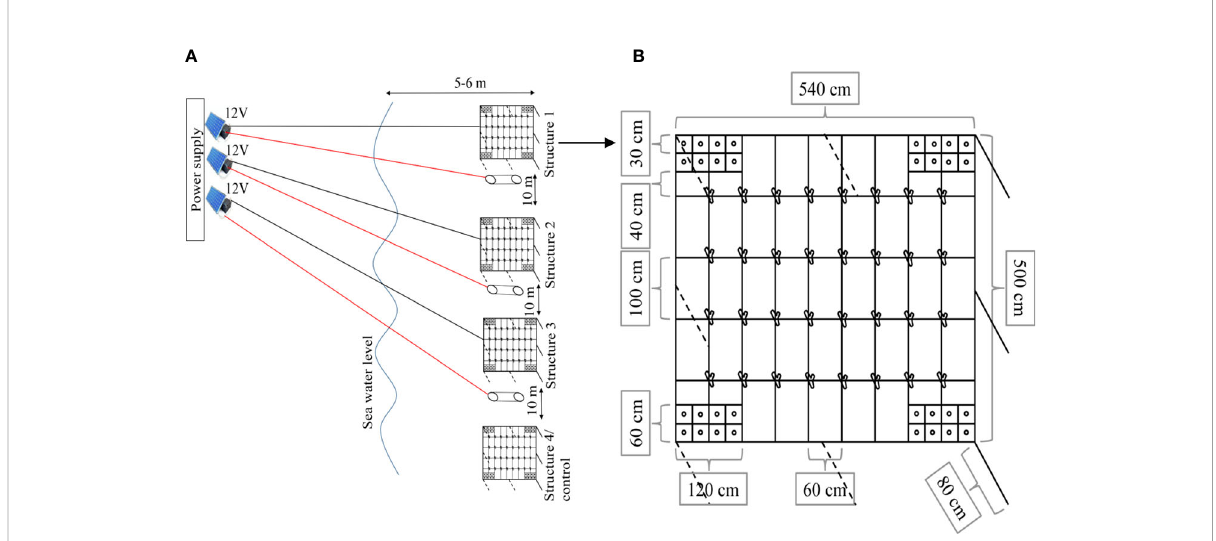
FIGURE 2 Design and setup of electro-stimulated structures for coral transplantation (A) , the schematic of cathode structure with the positions for massive and branching transplants (B) . All fragments were randomly distributed on structures with cable ties for branching (intersection between two iron bars) and epoxy for massive (metallic plate at four